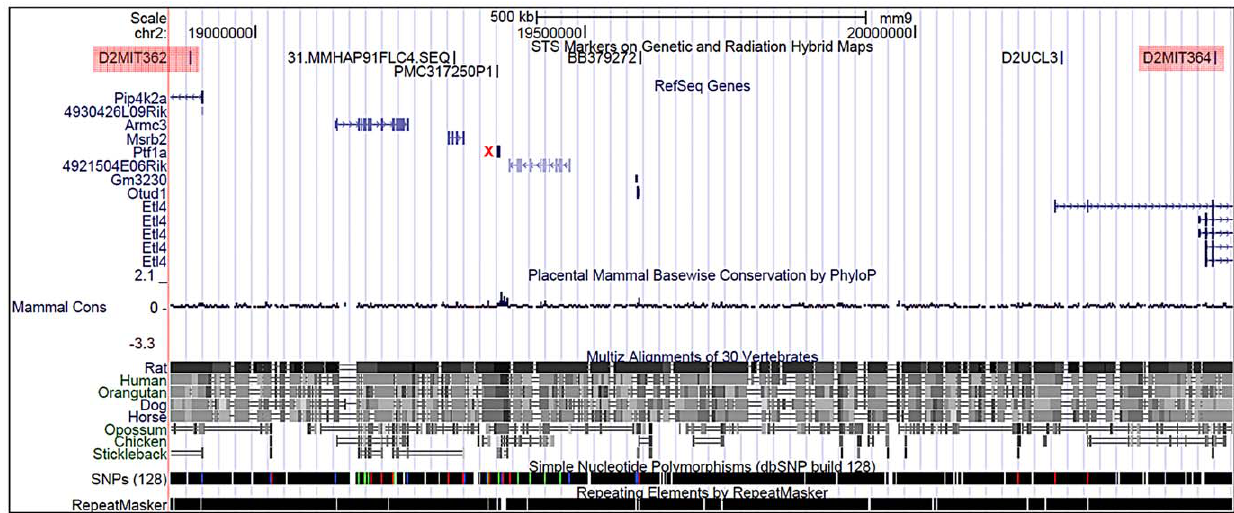
Figure 2. Physical map of the Sd critical region as viewed on the UCSC genome browser (http://www.genome.ucsc.edu). The Sd region on chromosome 2 is defined by the flanking genetic markers D2Mit362 proximally and D2Mit364 distally (markers are highlighted in red) and represented by bases 18,686,882–20,915,358 on the July 2007 genome build (mm9). The Sd critical region contains 11 known genes. The mutation location is denoted by the red X.